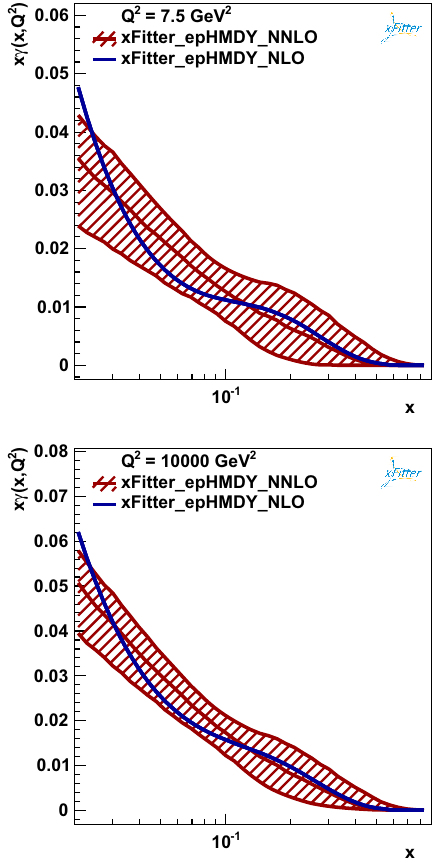
Fig. 9 Upper plot The impact on the photon PDF x γ( x , Q 2 ) from Fig. 10 Upper plot comparison between the reference xFitter_epHMDY in fits where a number of additional free parame- xFitter_epHMDY fit of x γ( x , Q 2 ) , based on NNLO QCD and tersareallowedinthePDFparametrisationEq.(3).Theparametrisation NLO QED theoretical calculations, with the central value of the variations that have been explored are: more flexibility to the gluon dis- corresponding fit based on NLO QCD and QED theory, at Q 2 = 7 . 5 tribution, allowing it to become negative (labeled by “neg”), adding on GeV 2 . In the former case, only the experimental Monte Carlo PDF top D u v , and then adding D ¯ u + D ¯ . Lower plot Comparison between uncertainties are shown. Lower plot Same comparison, now presented d the xFitter_epHMDY determinations obtained with the Monte Carlo at the higher scale of Q 2 = 10 4 GeV (baseline) and with the Hessian methods, where in both cases the PDF error band shown corresponds to the 68% CL uncertainties